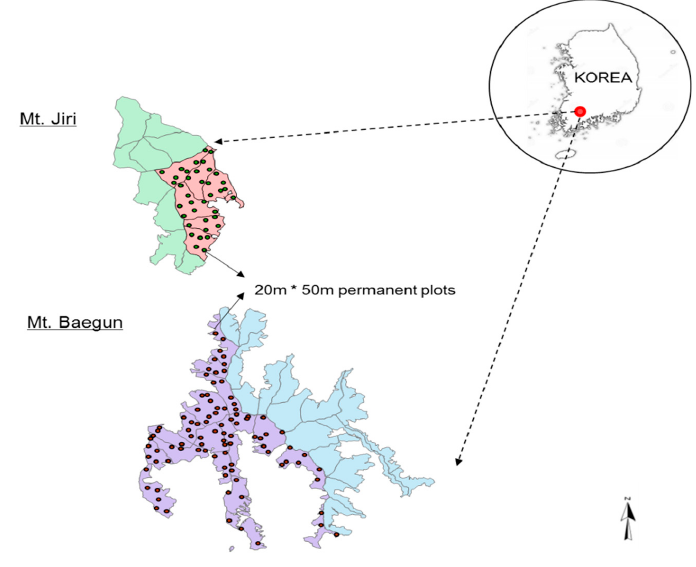
Figure 1. Location of 130 forest permanent plots across Mt. Jiri and Baegun.